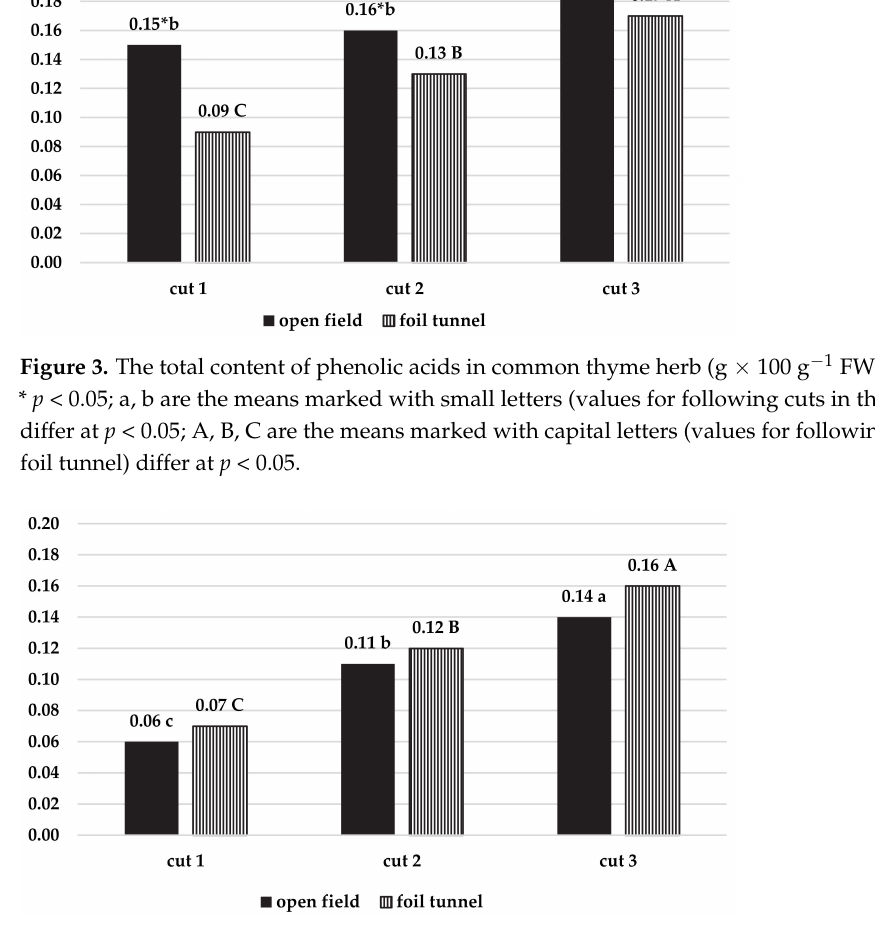
Figure 4. The total content of flavonoids in common thyme herb (g × 100 g − 1 FW). Tukey test; * p < 0.05; a, b, c are the means marked with small letters (values for following cuts in the open field) differ at p < 0.05; A, B, C are the means marked with capital letters (values for following cuts in the foil tunnel) differ at p <